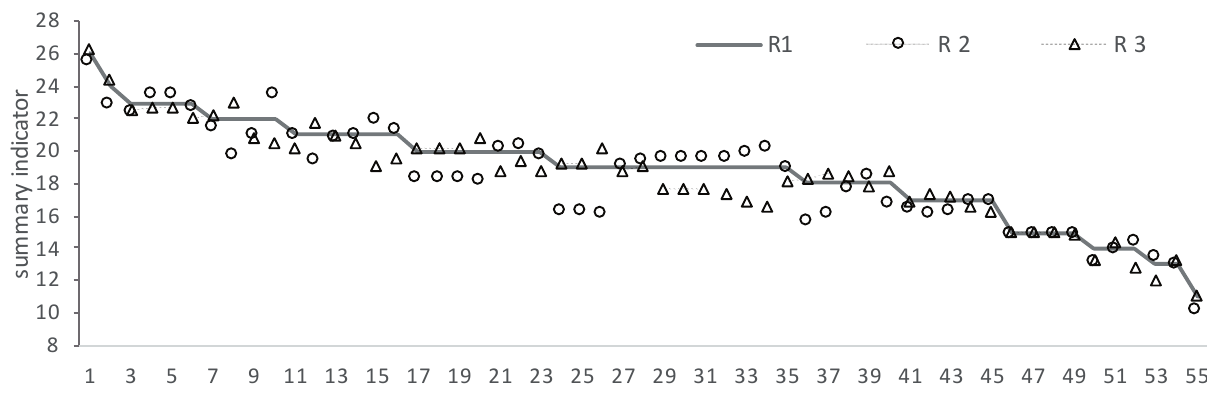
Figure 3. Graphic representation, for each alternative axis (X axis) of the summary indicator (Y axis) performed on the basis of R2 and R3 with those obtained from the assignment of the criteria of the Technical